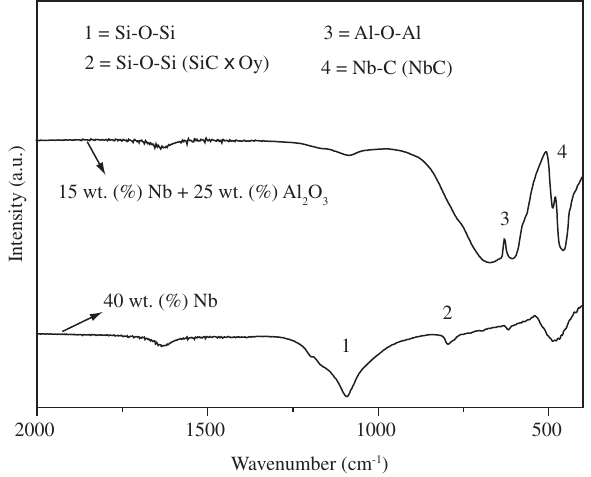
Figure 5. FTIR spectra of the composite material with 40 wt. (%) Nb and 15 wt. (%) Nb + 25 wt. (%) alumina sintered at 1400 °C.